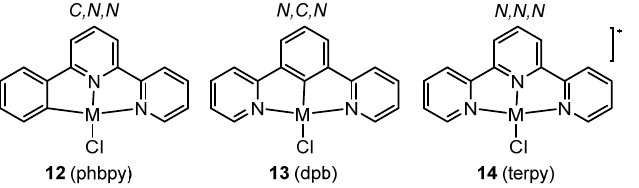
Figure 6. Neutral complexes with cyclometalating C,N,N and N,C,N coordinating ligands. phbpy and dpb compared with the analogous cationic complexes with the N,N,N coordinating terpy.